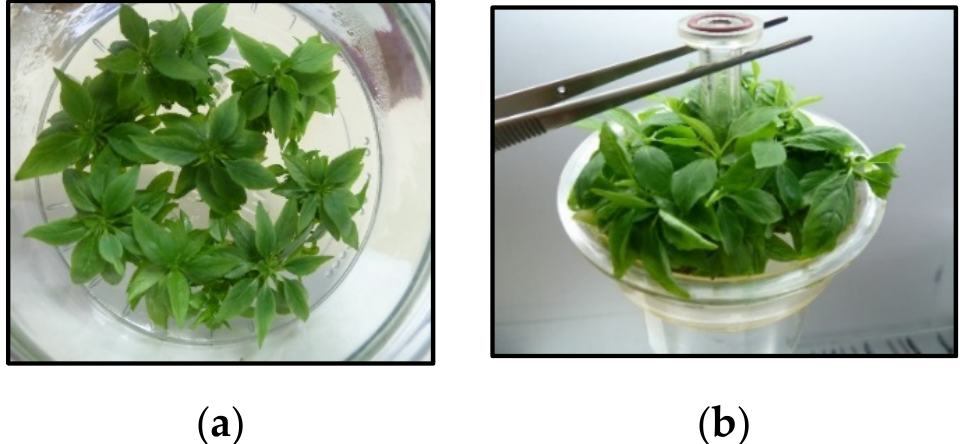
Figure 4. CFN shoots cultured in jars ( a ) and in bioreactors ( b ) in MS supplemented with 0.5 mg L − 1 BA, 0.5 mg L − 1 IBA and 3% sucrose.